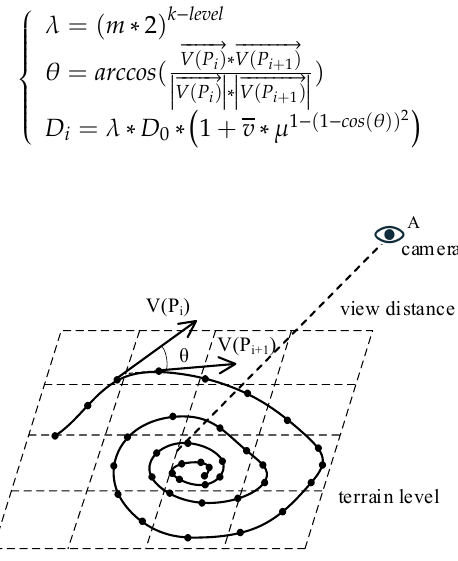
Figure 9. Adaptive streamline rendering.